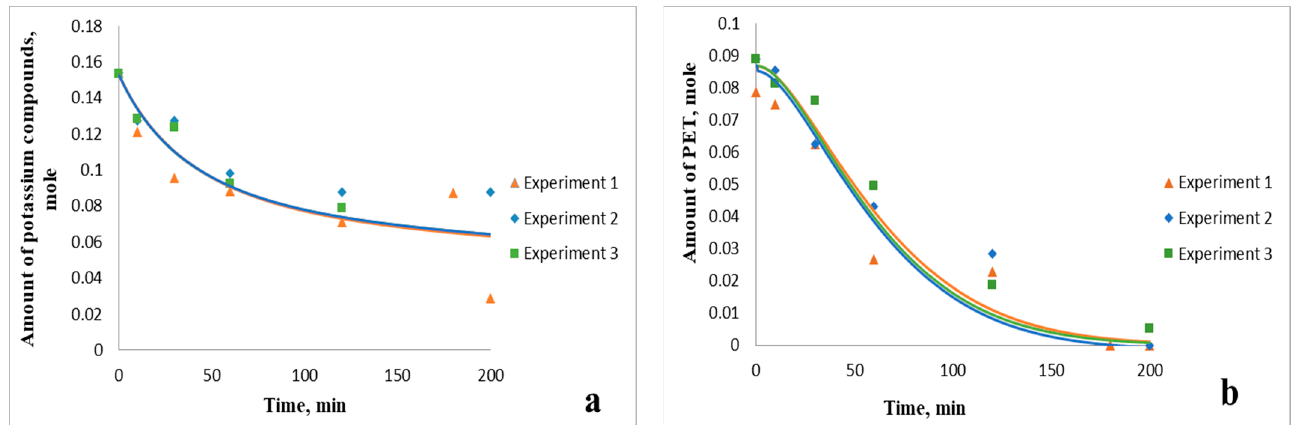
Figure 15. Experimental (dots) and calculated (lines) amounts of potassium compounds ( a ) and PET ( b ) at 170°C and the initial amount of PET 0.156 mol: Experiment 1—an initial amount of FAMEs of 0.04 mole; Experiment 2—an initial amount of FAMEs of 0.07 mole; Experiment 3—an initial amount of FAMEs of 0.11 mole.